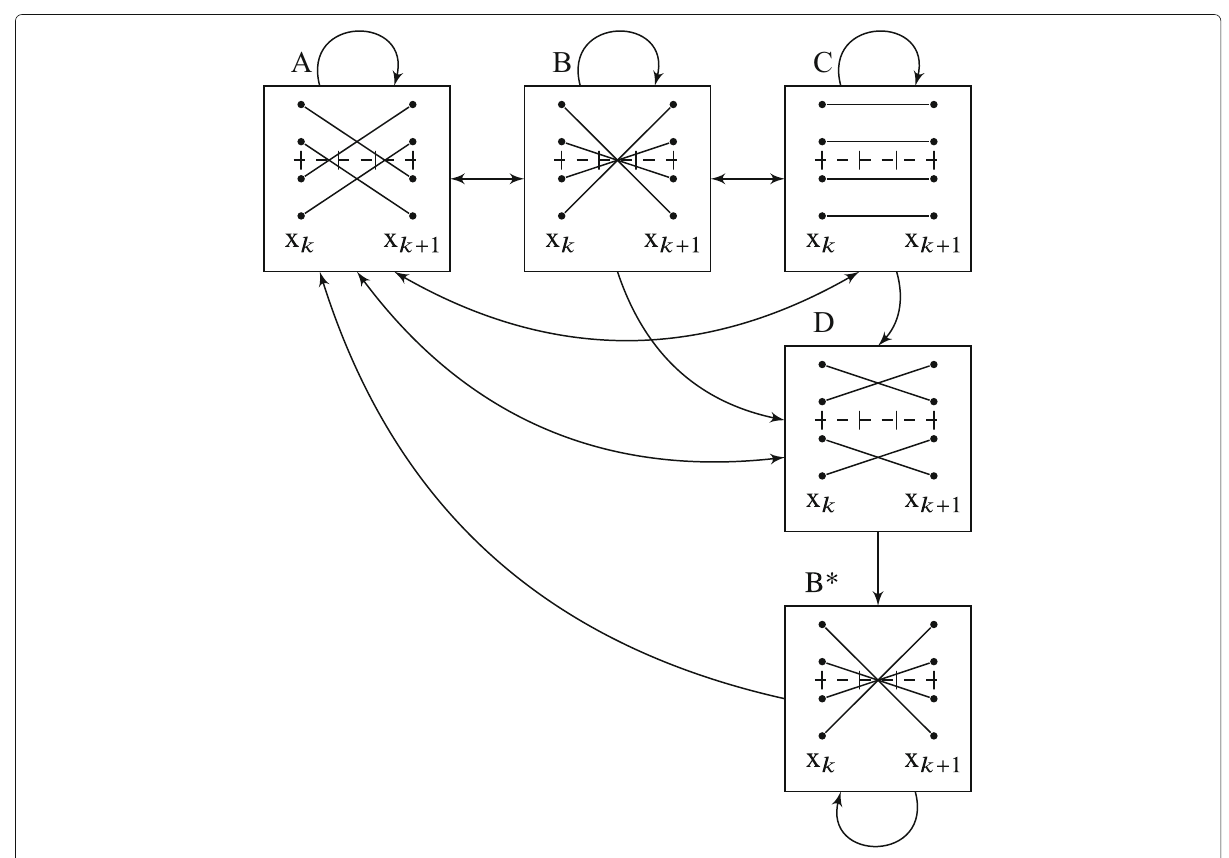
(cid:6) x k | x k − 1